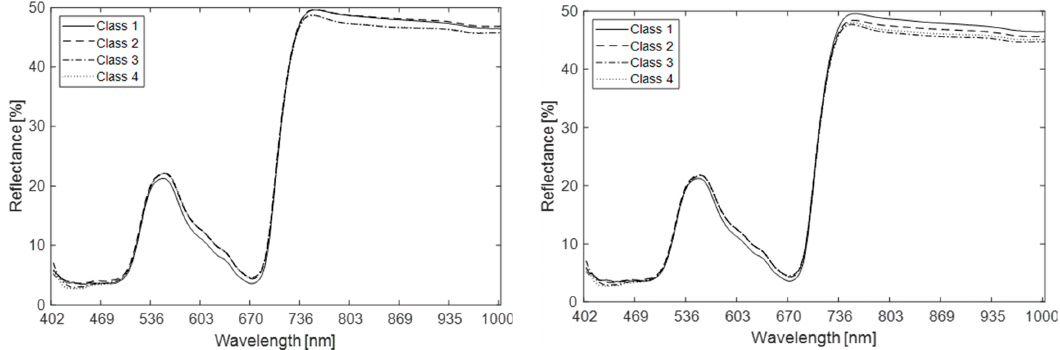
Figure 2. Summary of the mean raw spectral reflectance percentage profile for each one of the four different classes before ( left graph ) and after ( right graph ) the outlier elimination.